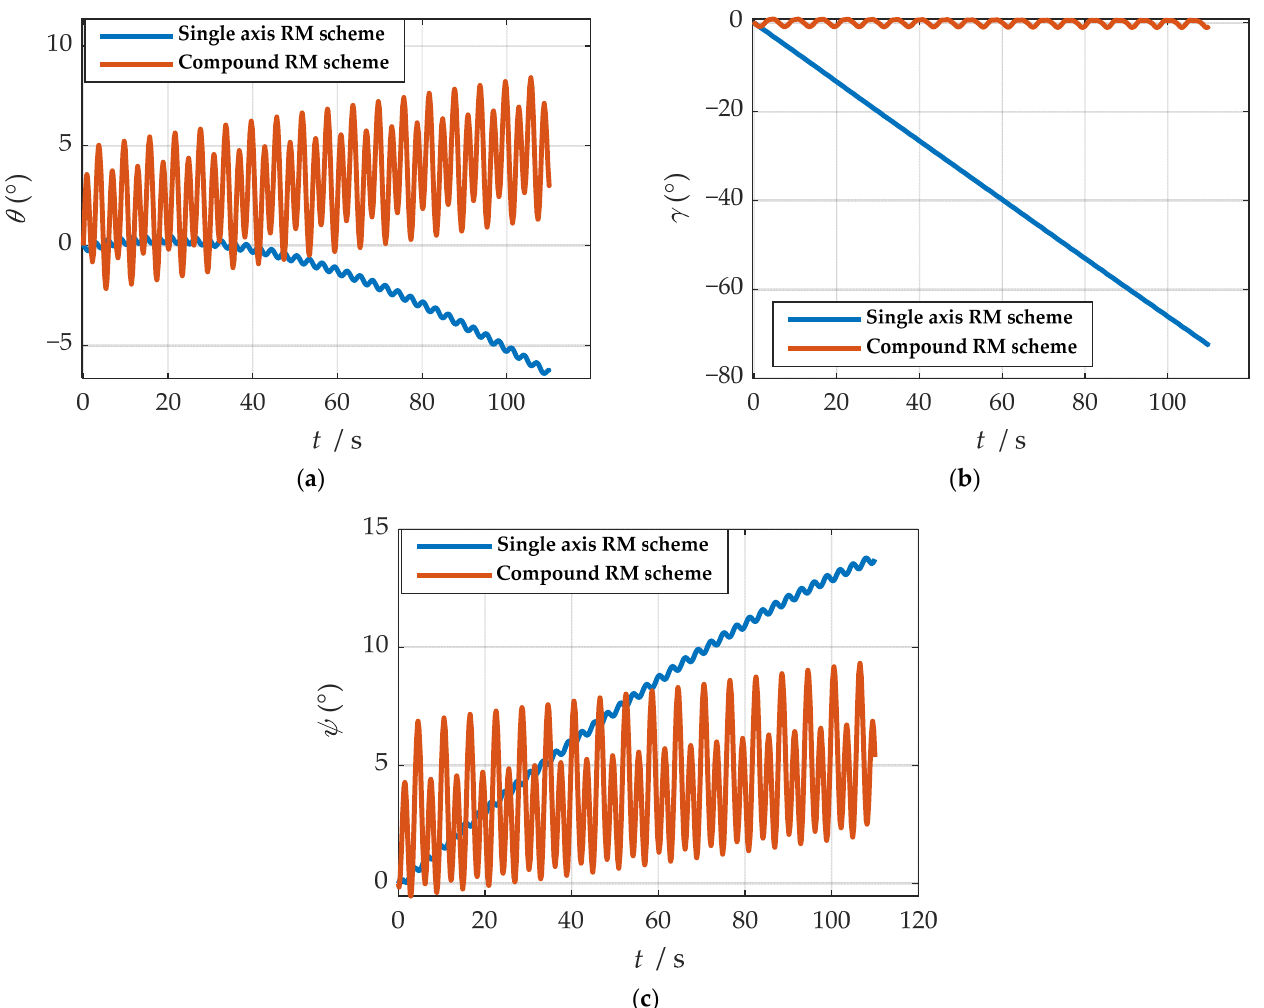
Figure 23. Comparison of attitude solution results: ( a ) comparison of calculation results of yaw angle; ( b ) comparison of